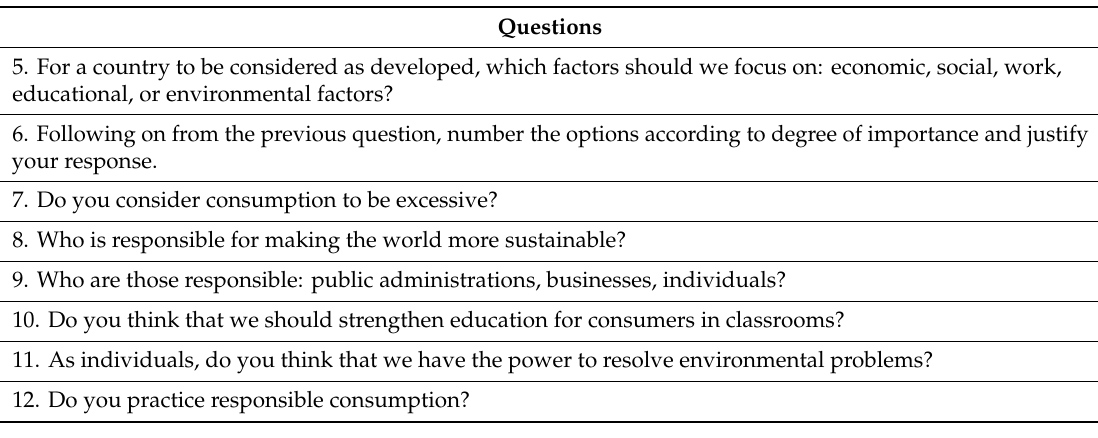
Table A1. Interview for the opinions of the future teachers